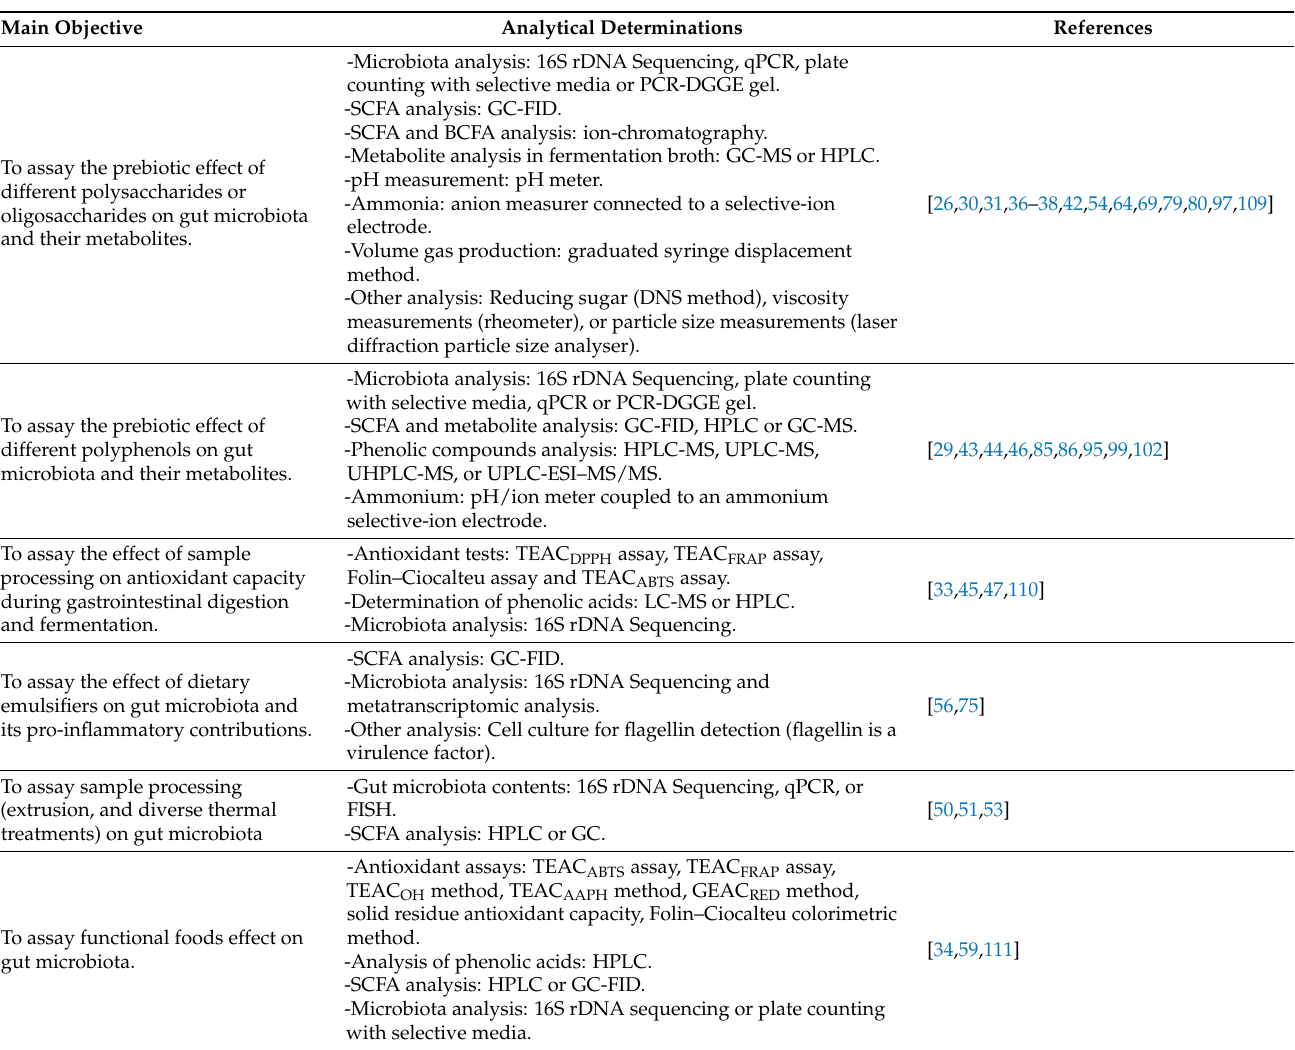
Table 3. Analytical techniques used to assess in vitro gut